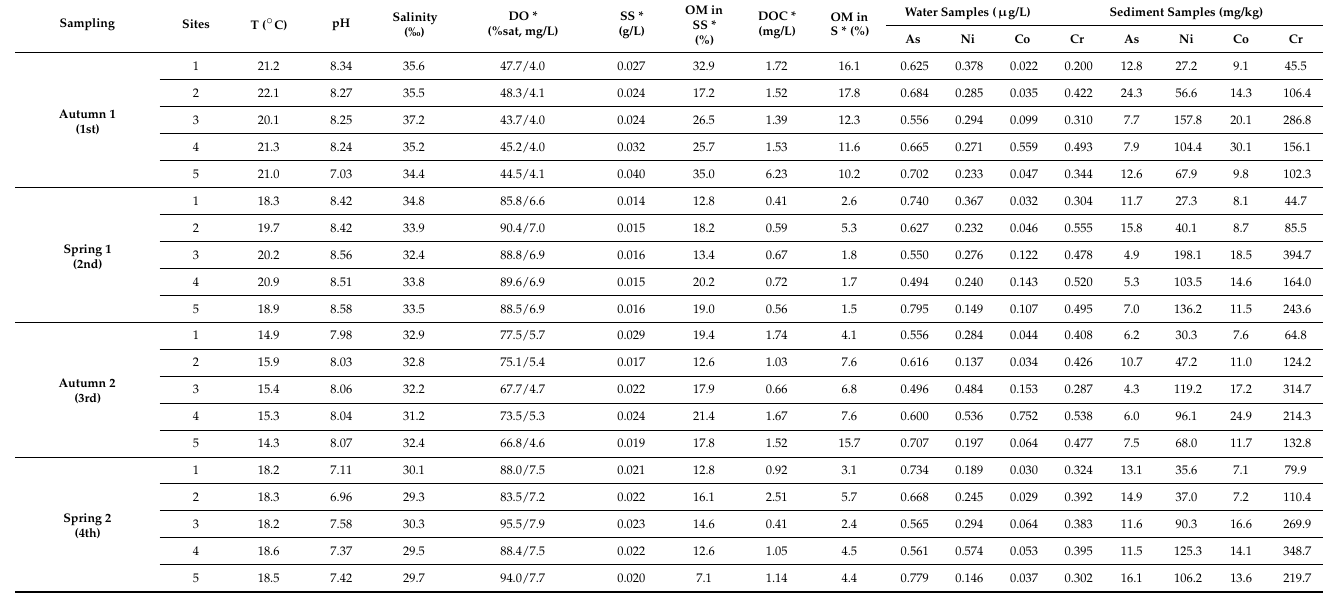
Table 2. Characterisation of the Algeciras Bay